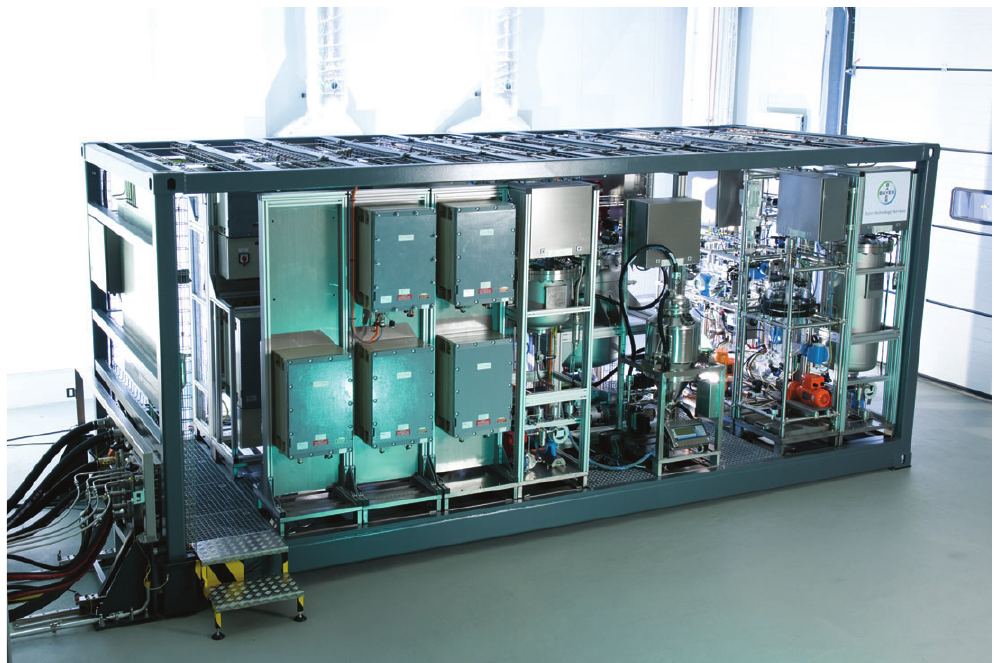
Figure 2 Container based modular production unit for continuous API-production currently tested at the INVITE Research Center. © INVITE